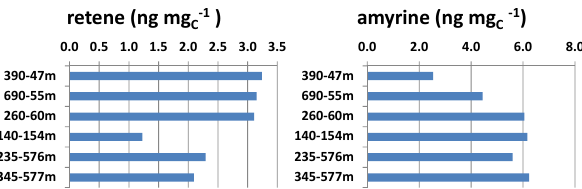
Fig. 12. TOC-normalized concentration of retene and α -amyrin in surface sediments from the shelf, Amundsen Gulf and slope.